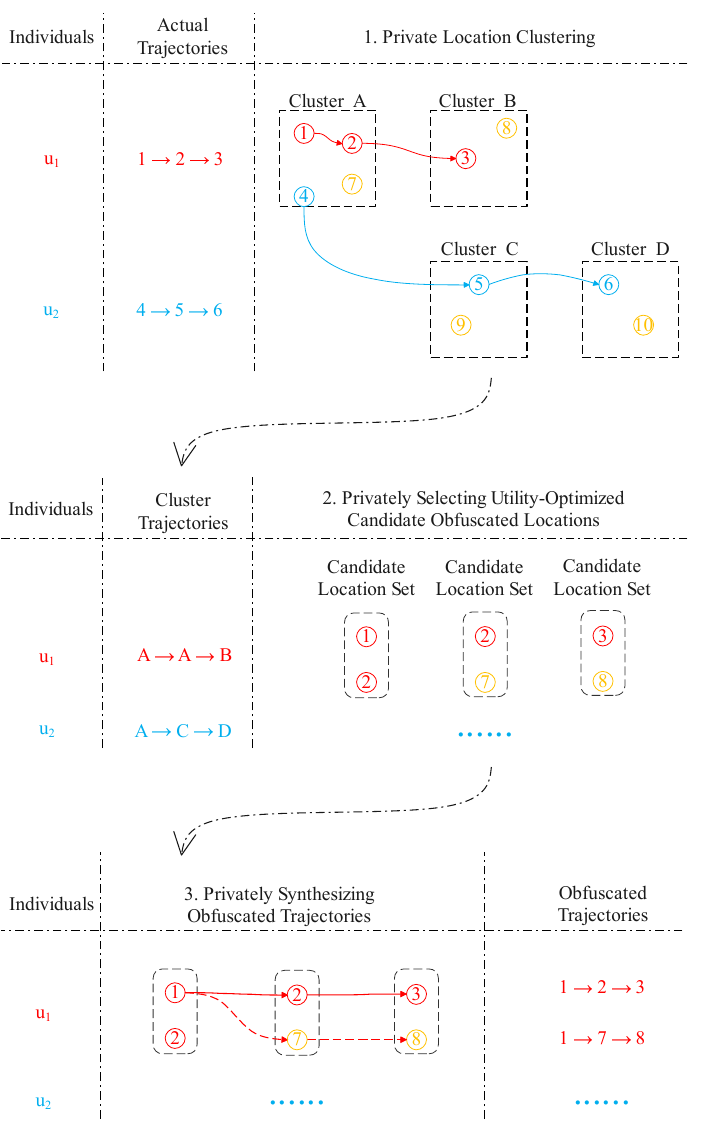
Figure 2. An example of releasing differentially private and utility optimized trajectories with UDPT. We focus on two moving individuals, namely u 1 and u 2 , represented by red and blue colors, respectively. A location is denoted by a number. The yellow numbers represent the locations visited by other